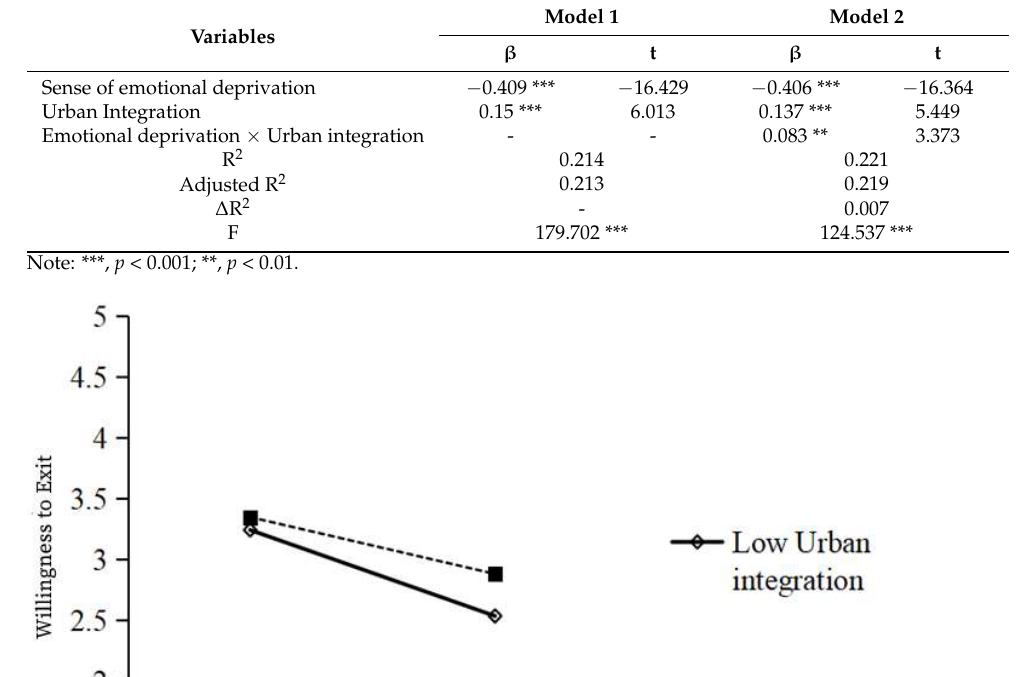
Table 15. Test of the moderating effect of urban integration on the relationship between emotional deprivation and willingness to withdraw.